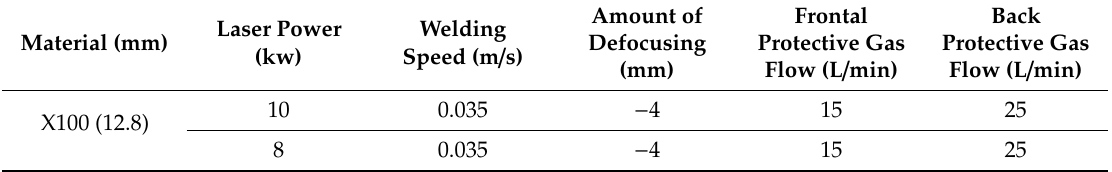
Table 2. Parameters for the laser welding of the pipeline steel.